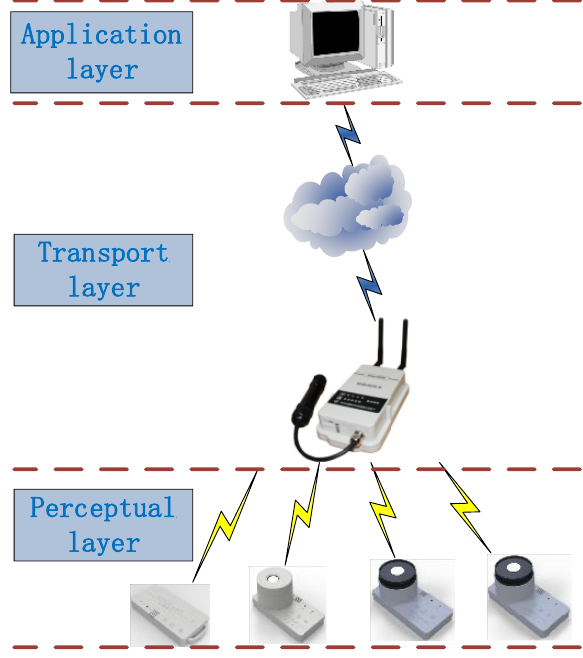
Figure 7. Topology of the IoT system for the tower crane.